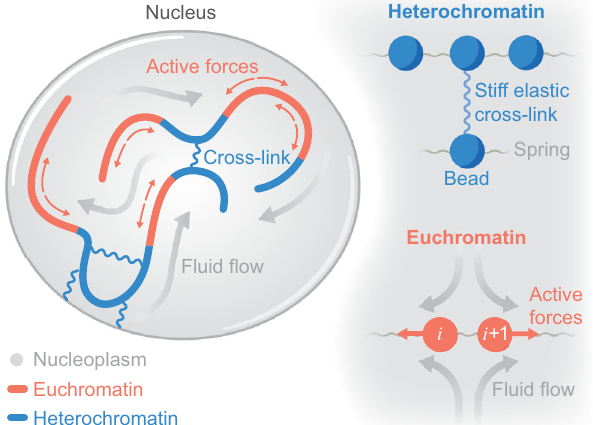
FIG. 1. Model schematic. M c bead-spring polymer chains representing individual chromosomes are confined inside a spheroidal nuclear envelope. Heterochromatic (HC) blocks can form interchromosomal and intrachromosomal cross-links as well as tethers with the nuclear envelope, whereas euchromatic (EC) blocks are decorated with active force dipoles that drive nucleoplasmic